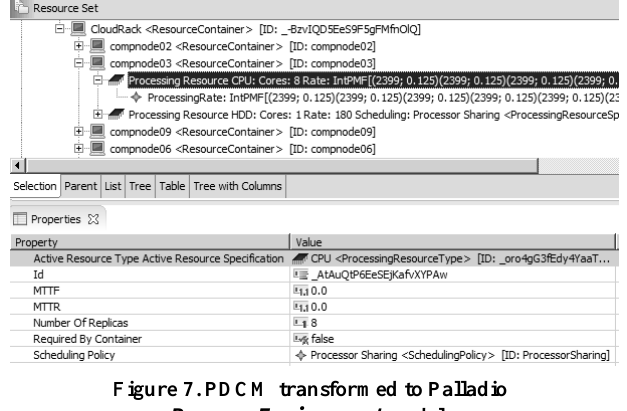
Figure 7. PDCM transformed to Palladio ResourceEnvironment model.